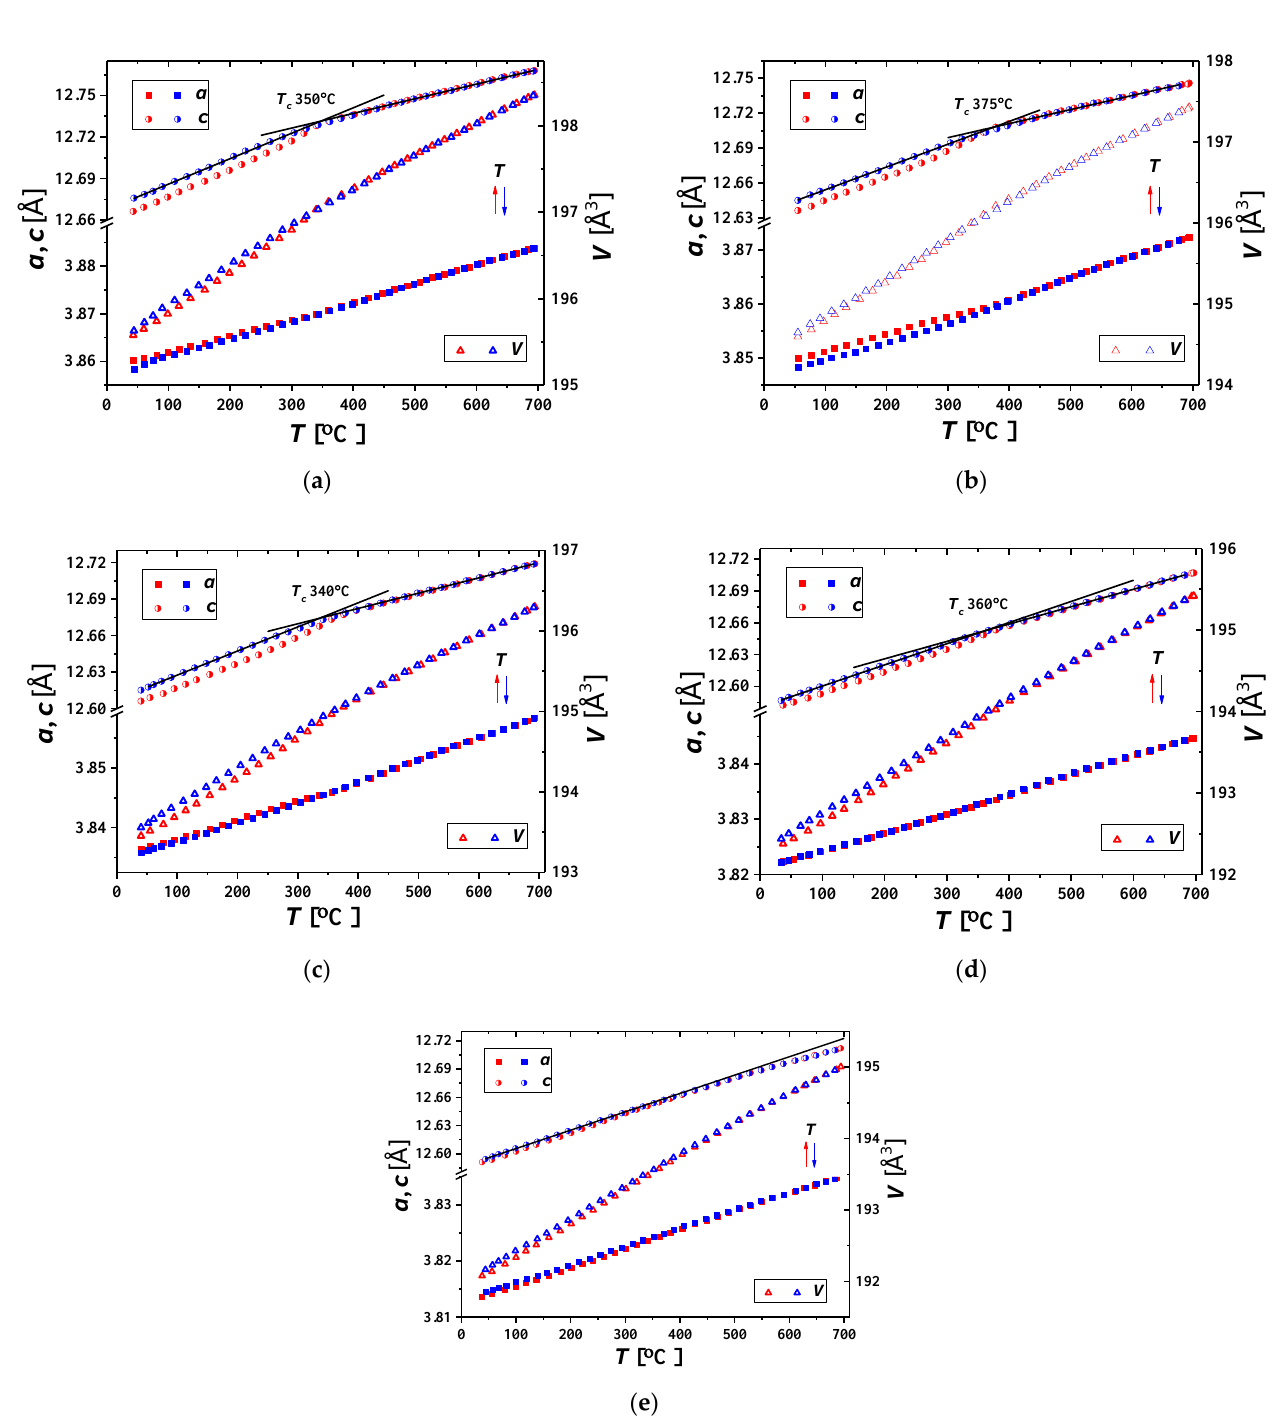
Figure 6. Temperature dependences of the unit cell parameters and volumes for the samples: La 2 NiO 4+ δ ( a ), La 1.9 Ca 0.1 NiO 4+ δ ( b ) La 1.8 Ca 0.2 NiO 4+ δ ( c ), La 1.7 Ca 0.3 NiO 4+ δ ( d ) and La 1.6 Ca 0.4 NiO 4+ δ ( e ) collected in synthetic air. Black lines are the linear approximations for the c parameter (cooling mode) in the temperature ranges of 50–250 ◦ C and 500–700 ◦ C. Red and blue symbols represent the heating and cooling modes, respectively. In Situ XRD data were obtained at the precision diffractometry-2 station (SSRTC, Novosibirsk) at a wavelength of 0.101